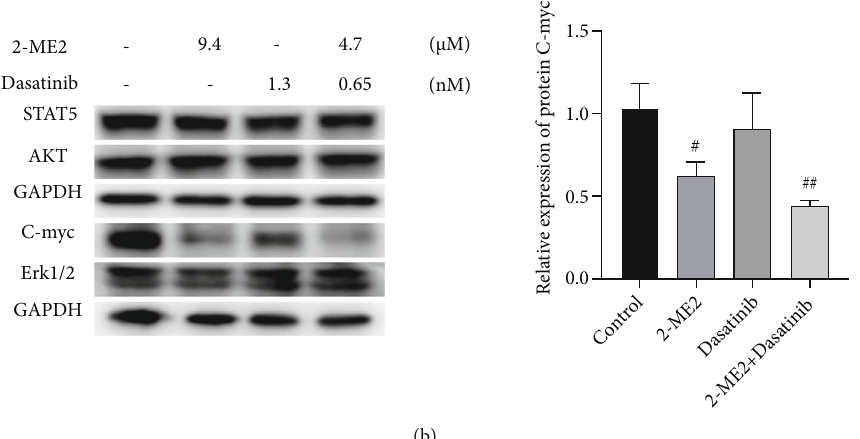
Figure 6: The e ff ects on K-562 cell apoptosis and the regulation of related pathways after 24 h of single and combined administration: (a) fl ow cytometry detection of cell apoptosis; (b) Western blot detection of protein expressions. Compared with control group, # P < 0 : 05 ; ## P < 0 : 01 .